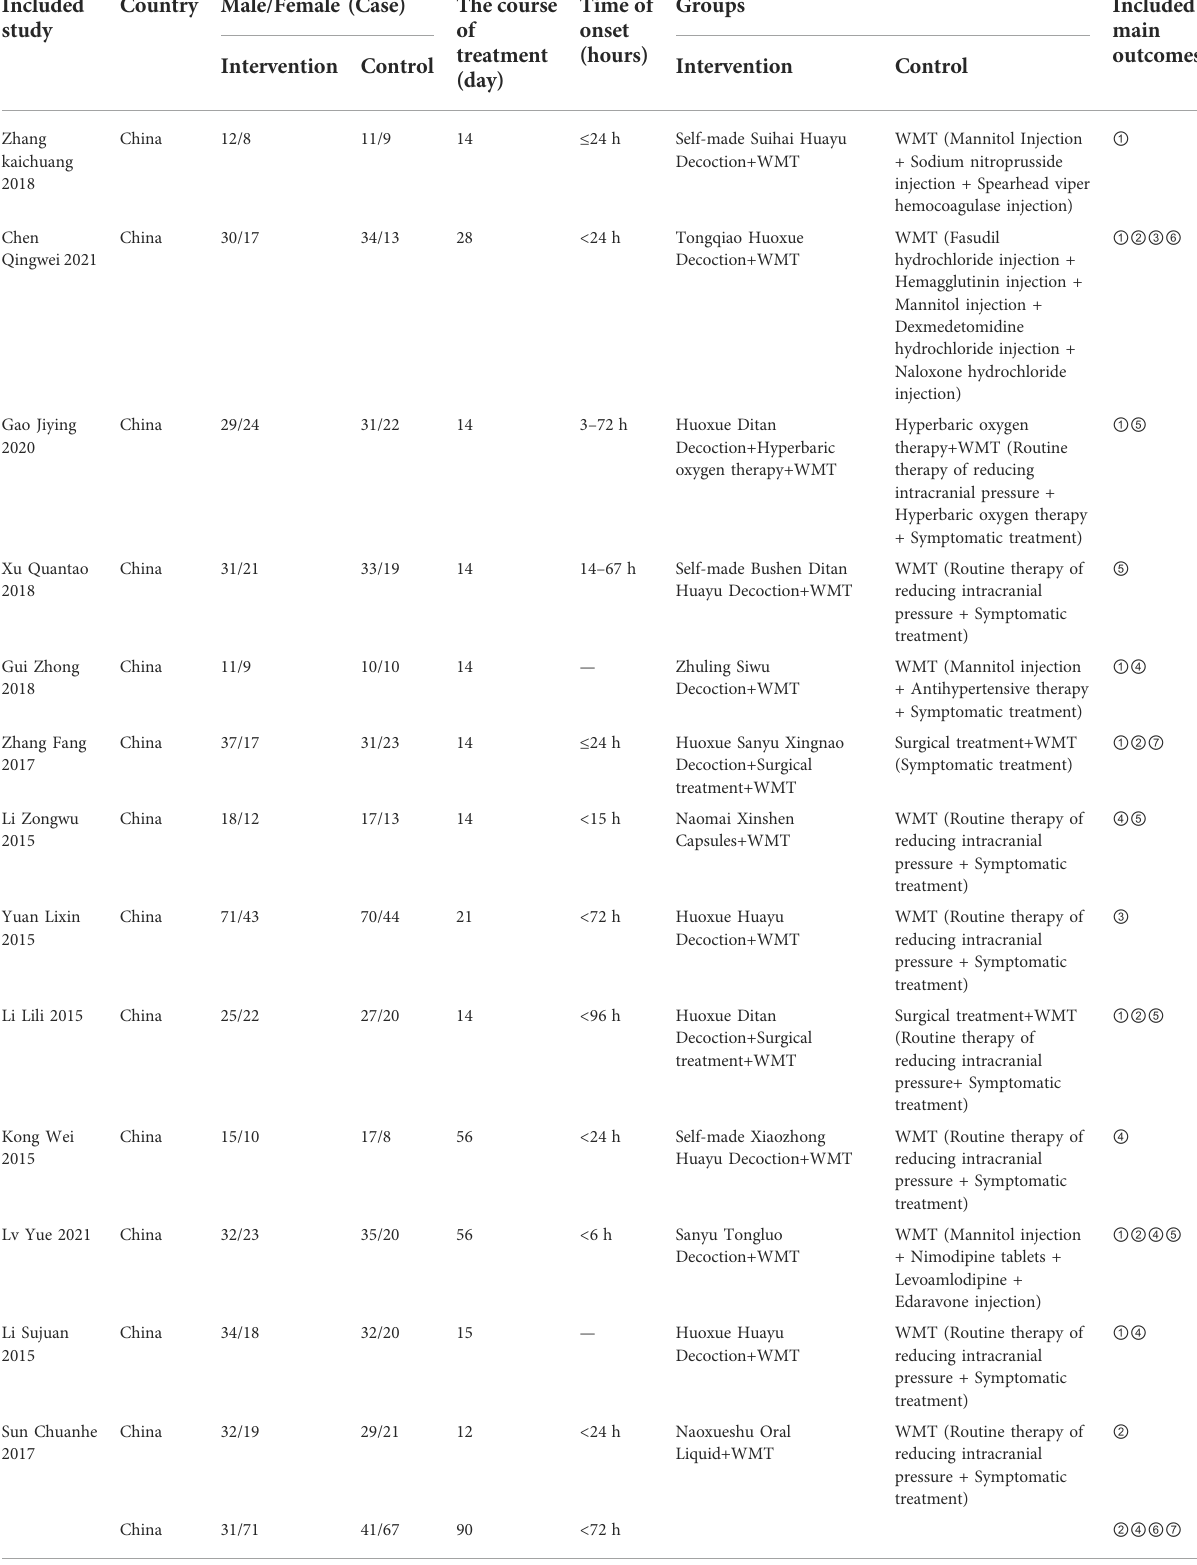
TABLE 1 Characteristics of the included